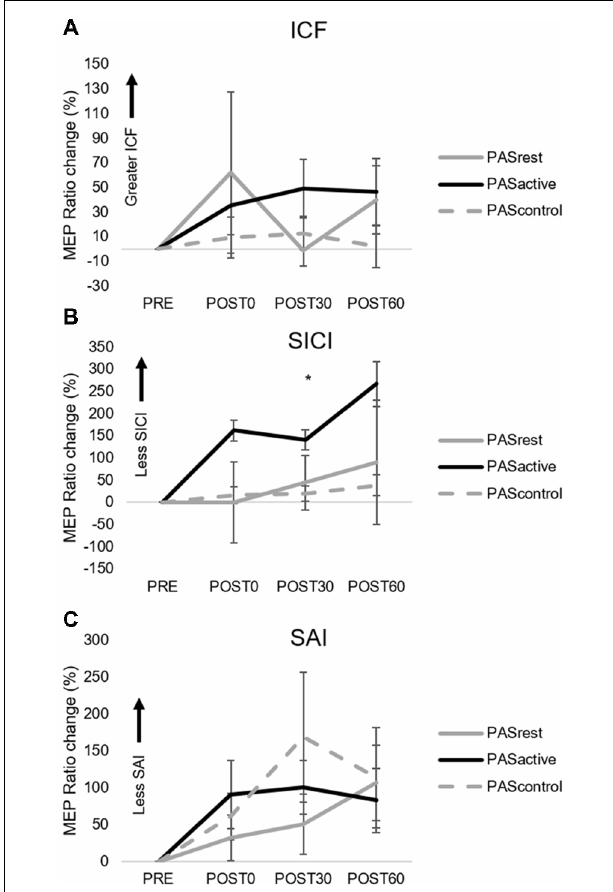
FIGURE 3 | Group normalized MEP amplitude (mean ± SE) during the PAS ACTIVE , PAS REST , and PAS CONTROL conditions for (A) ICF, (B) SICI, and (C) SAI TMS assessments. MEP ratio measures for SICI (B) demonstrated a main effect of condition ( ∗ p = 0.048), where PAS ACTIVE showed greater increase in MEP amplitude across post-testing time points compared to PAS REST and PAS CONTROL (SAI, short afferent inhibition; SICI, short interval intracortical inhibition; ICF, intracortical